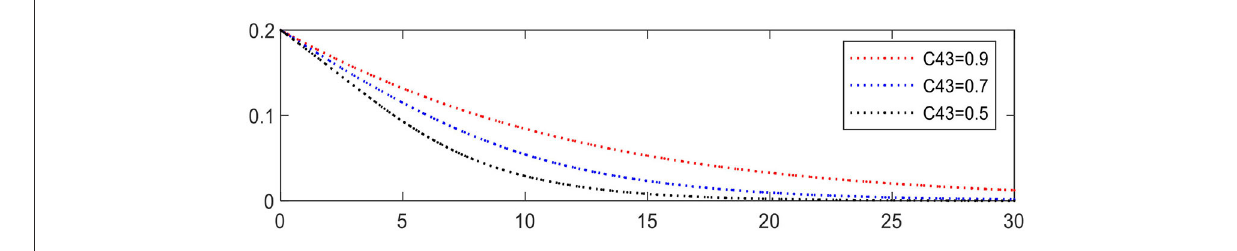
FIGURE9 Evolution of chronic disease patients (different C 43 ).